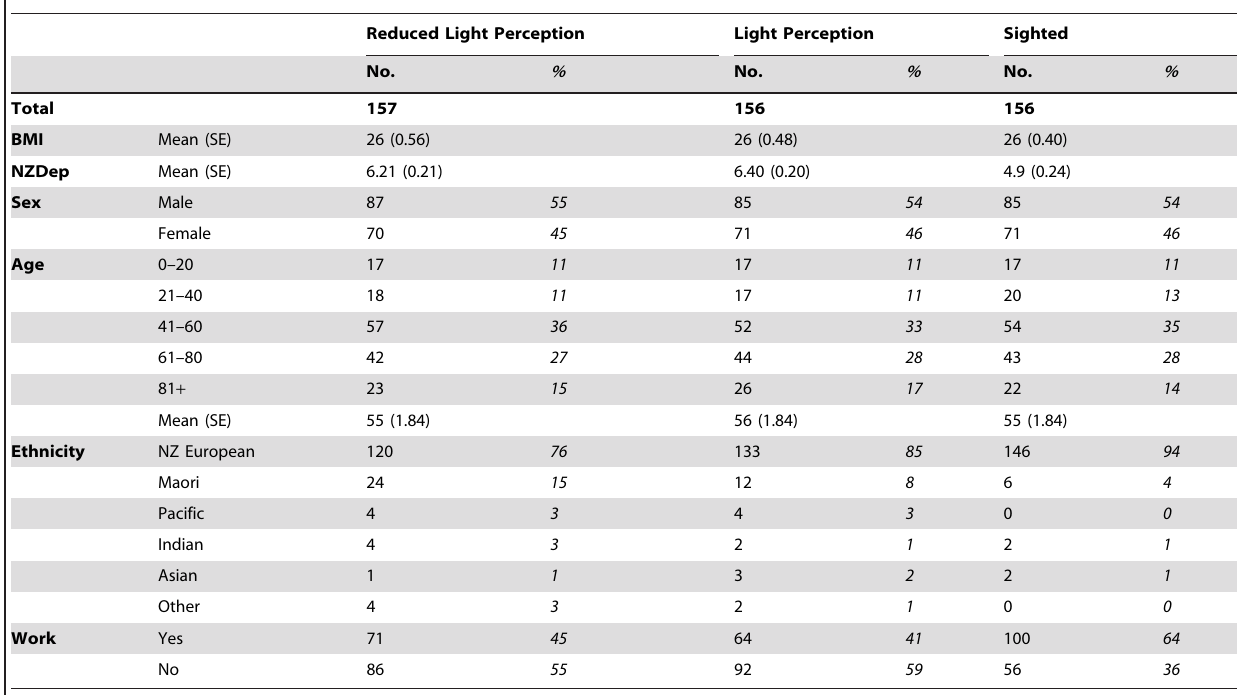
Table 1. Demographics of the participants in the survey (total n= 469).